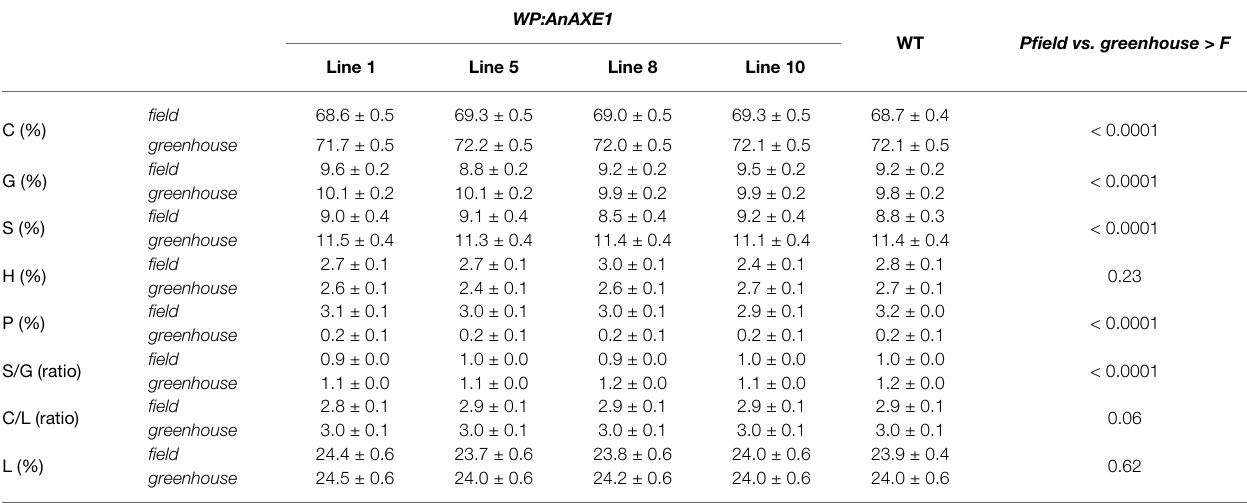
TABLE 3 | Chemical composition, S/G and C/L ratios, and lignin contents, according to pyrolysis-gas chromatography mass spectrometry, of lignocellulose of WP:AnAXE1 and WT lines grown in the field and